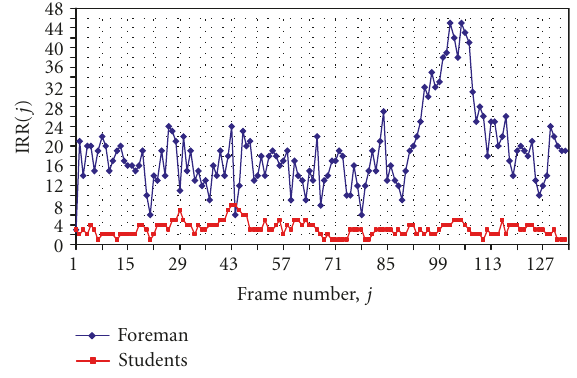
Figure 7: The intra-refresh rate computed for the “Foreman” and “Students”